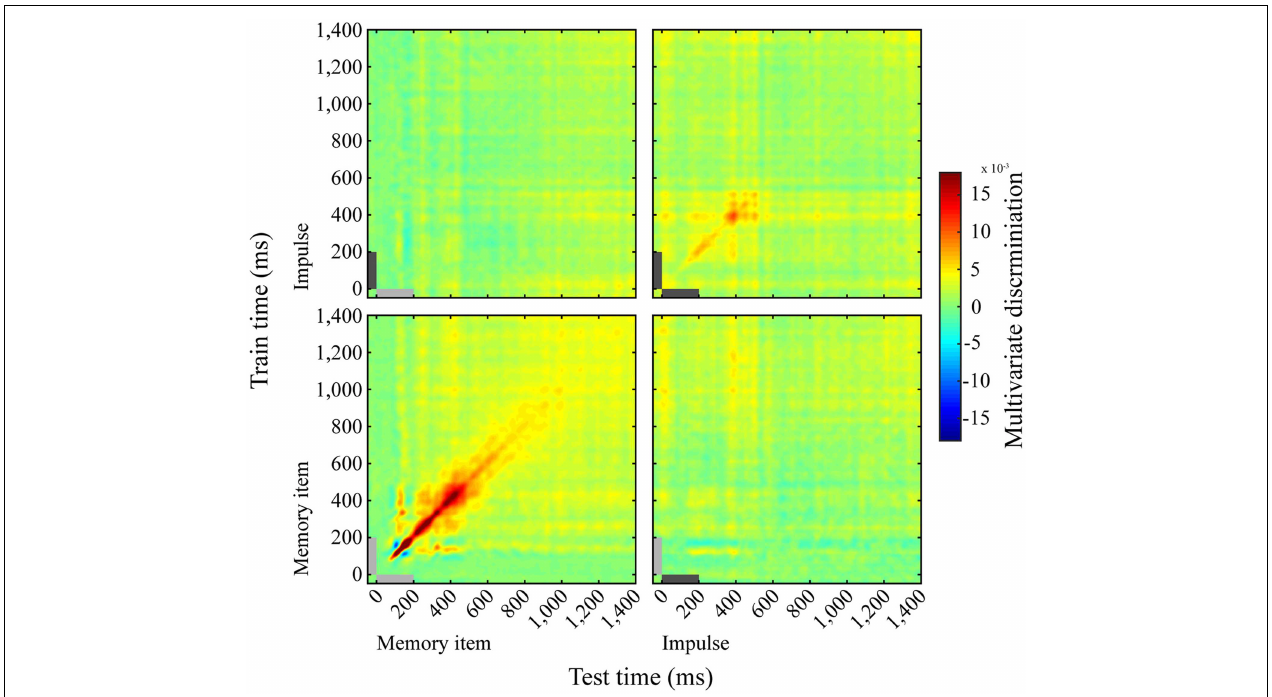
FIGURE 6 | Dynamics of memory item discrimination. Mean discrimination matrices derived from training and testing on all time-point combinations. Light-gray and dark-gray bars represent memory item and impulse presentation, respectively.